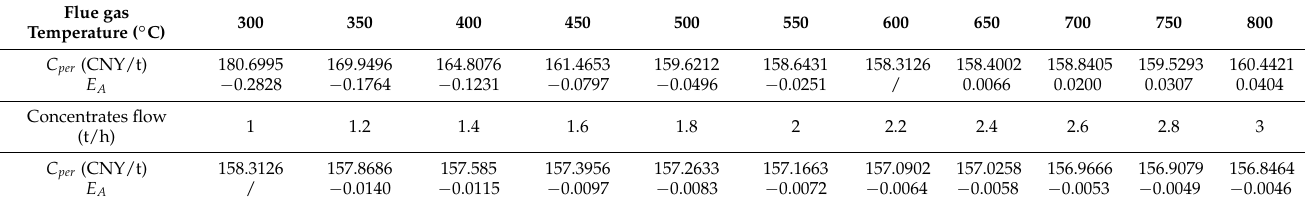
Table 5. Sensitivity analysis of the handling capacities of the concentrates and the temperature of the extracted flue